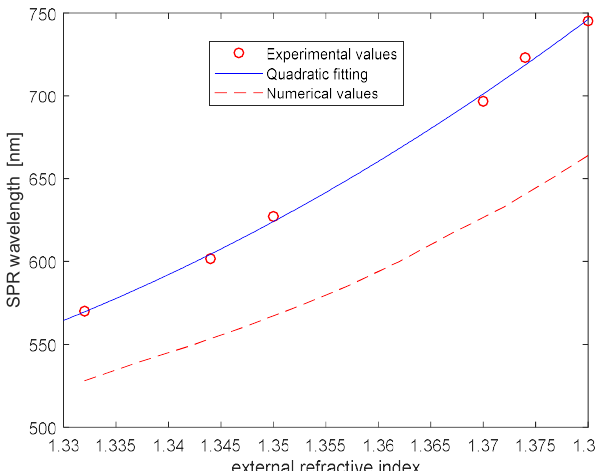
Figure 4. Resonance wavelength as a function of the surrounding refractive index: the circles are obtained from experimental data, and the dashed line is the result of numerical computations, while the quadratic fitting curve of the experimental values is reported by the continuous blue line.